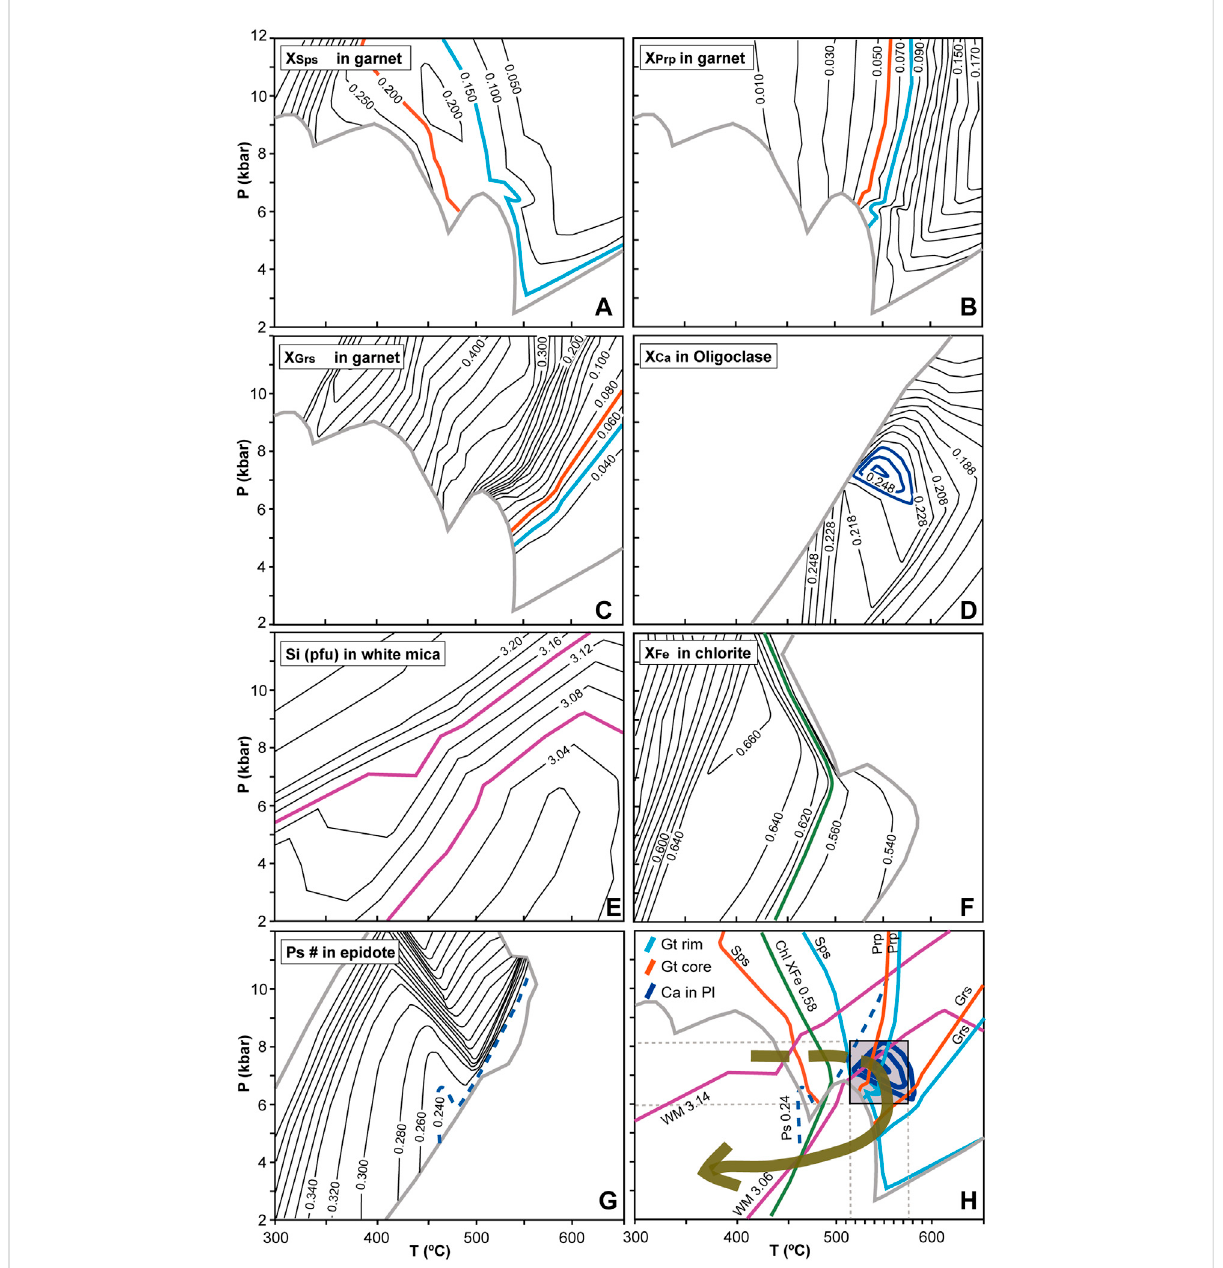
FIGURE 11 Calculated isopleths of mineral composition for the sample FO1710 with PERPLE_X. Selected isopleths for the thermodynamic model are presented in X Sps in the garnet (A) , X Prp in the garnet (B) , and X Grs in the garnet (C) , which show the model of core and rim garnet composition in orange and light blue, respectively. The garnet stability fi eld limit is presented in gray. Following diagrams show the selected isopleths of X Ca in oligoclase (D) , Si (pfu) in white mica (E) , X Fe in chlorite (F) , and Ps # in epidote (G) , which are presented in blue, purple, green, and dashed blue lines, respectively. The mineral stability limits are presented in gray. (H) Thermodynamic model obtained by the information gathered in (A – F) showing relevant isopleths selected. The garnet equilibrium formation is pointed in a black square. The brown arrow shows the P – T path of the sample FO1710 suggested by the mineral composition, observed assemblages, and